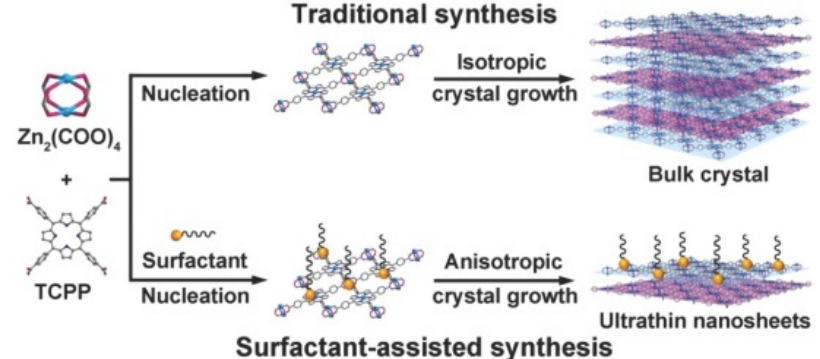
Figure 7. Scheme depicting the surfactant ‐ mediated synthesis of 2D MOFs. The traditional synthesis method yields bulk crystals due to isotropic growth. The incorporation of the surfactant on the MOF surface results in anisotropic growth, thereby producing ultrathin nanosheets. Reproduced from [47]. Copyright 2015 Wiley Materials.